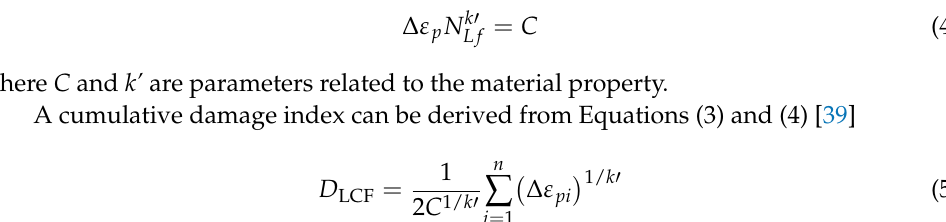
where ∆ ε pi is the plastic strain amplitude in each half load loop. This equation can be used to predict the LCF damage of the alloy steel subjected to plastic strain loads with different